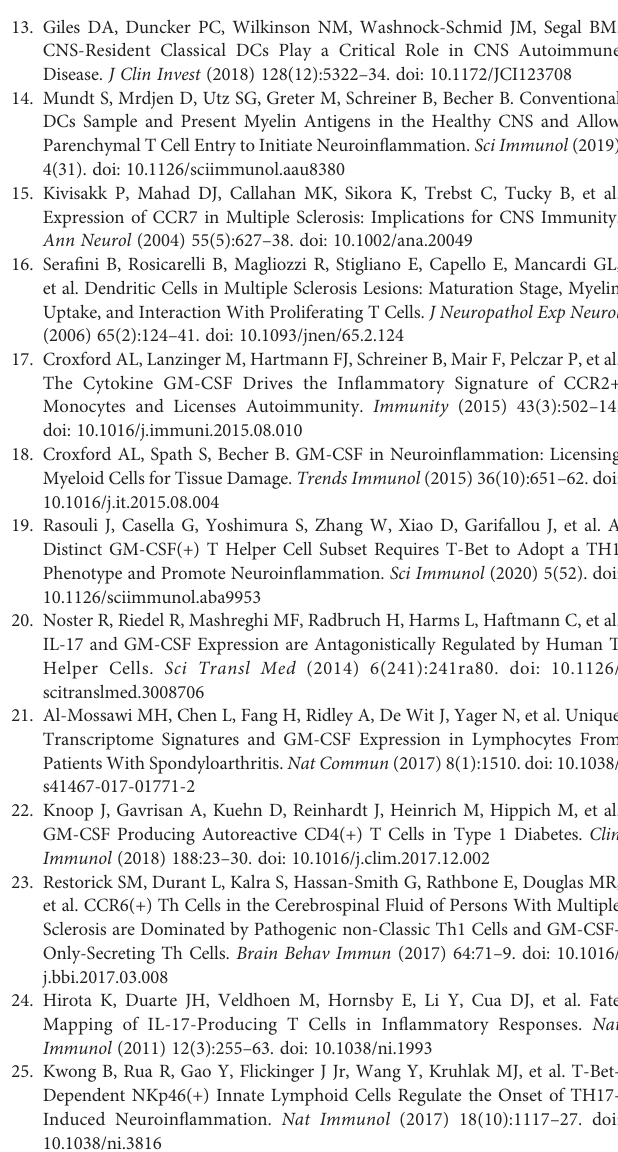
Supplementary Figure 1 | Sorting strategies for isolation of ThGM, Th1, and Th1-GM + cells. Total CD4 + T cells were puri fi ed from PBMCs using negative- selection CD4 isolation kit. T M cells were then puri fi ed from total CD4 + T cells with negative-selection CD45RA microbeads. T M cells were stained for CD4, CD45RA,